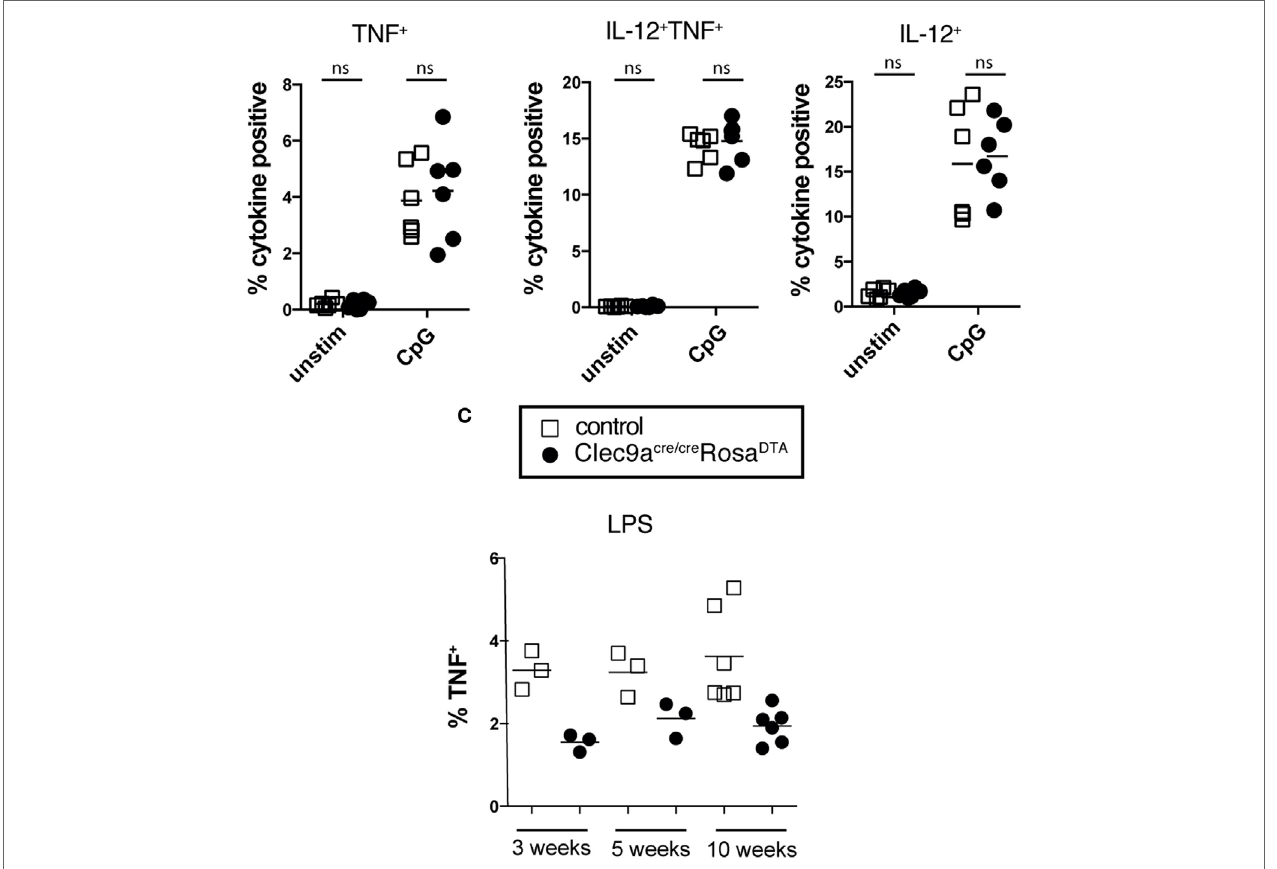
FigUre 4 | cDC2 from Clec9a Cre/Cre Rosa DTA mice phenotypically and functionally resemble cDCs. (a) Splenic CD11c + MHCII + CD11b + cells from control (red) and Clec9a cre/cre Rosa DTA (blue) mice were analyzed for the expression of indicated surface markers or transcription factors (lower line) by flow cytometry. Gray traces represent staining with isotype matched control antibody. (B,c) CD11c + cells from control and Clec9a cre/cre Rosa DTA mice of the indicated ages were enriched using magnetic beads, stimulated with lipopolysaccharide (LPS) (100 ng/mL) or CpG (0.5 µg/mL) for 6 h followed by intracellular cytokine staining. CD11c + MHCII + CD11b + cDC2 were identified by flow cytometry and TNF and IL-12 production was analyzed. (B) The frequency of cytokine positive cDC2 is shown. (c) Frequency of TNF producing cDC2 from mice of the indicated ages stimulated with LPS. Each data point represents one mouse. Data are compiled from two independent experiments. * p <